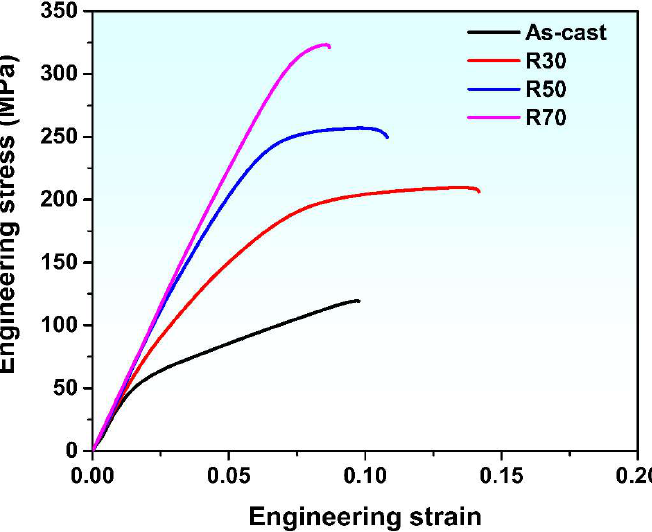
Figure 6. Engineering stress–engineering strain curves of as-cast and hot rolled alloys.